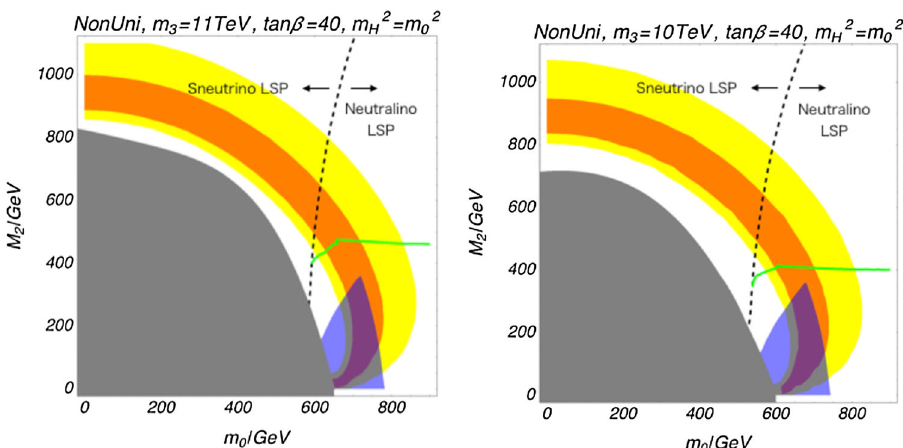
Table 2 A sample parameter point in the case of the non-universal gaugino masses. The neutralino is the LSP. (cid:7) h 2 and σ SI denote the current thermal relic abundance of the bino and the spin-independent bino-nucleon